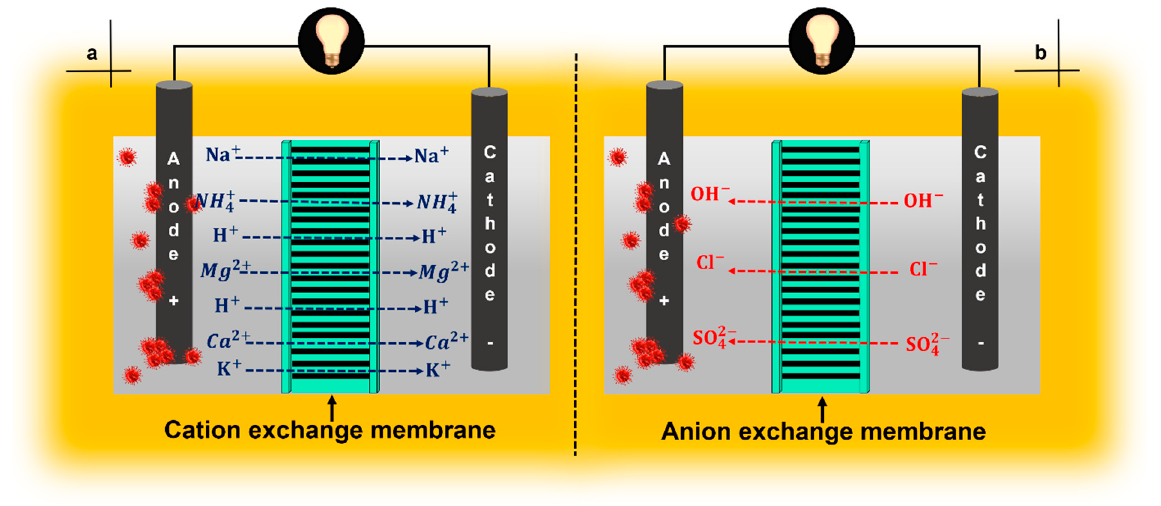
Figure 5. Main ions transported in a microbial fuel cell working with ( a ) a cation ‐ exchange membrane and ( b ) an anion ‐ exchange membrane.